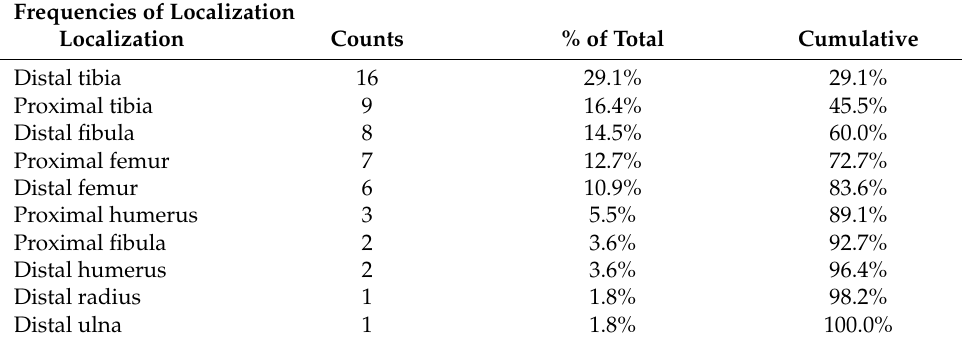
Table 1. Distribution of bone segment